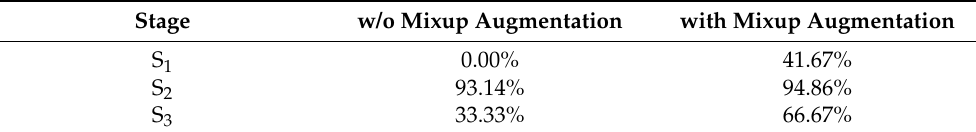
Table 3. Compare the CNN trained with or without mix-up augmentation in the male.